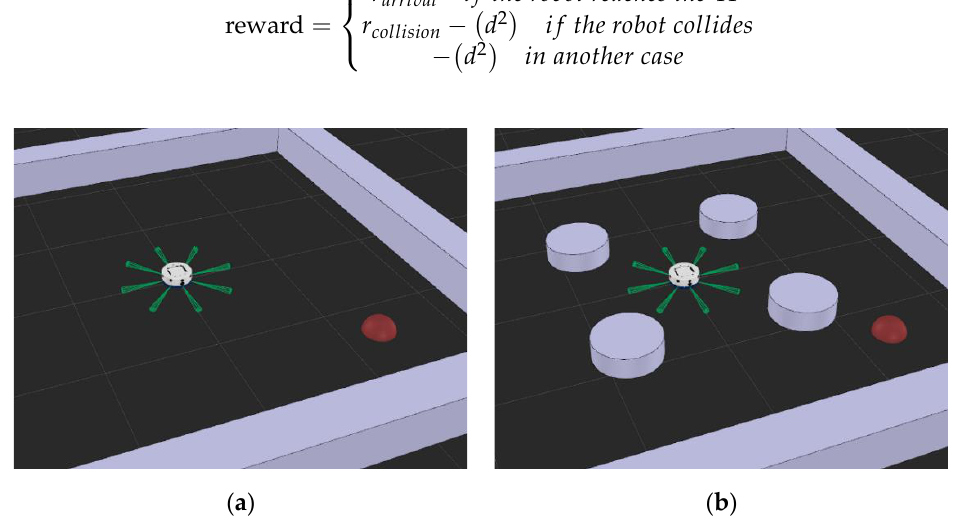
Figure 7. Environments for position control: ( a ) without obstacles; ( b ) with obstacles.